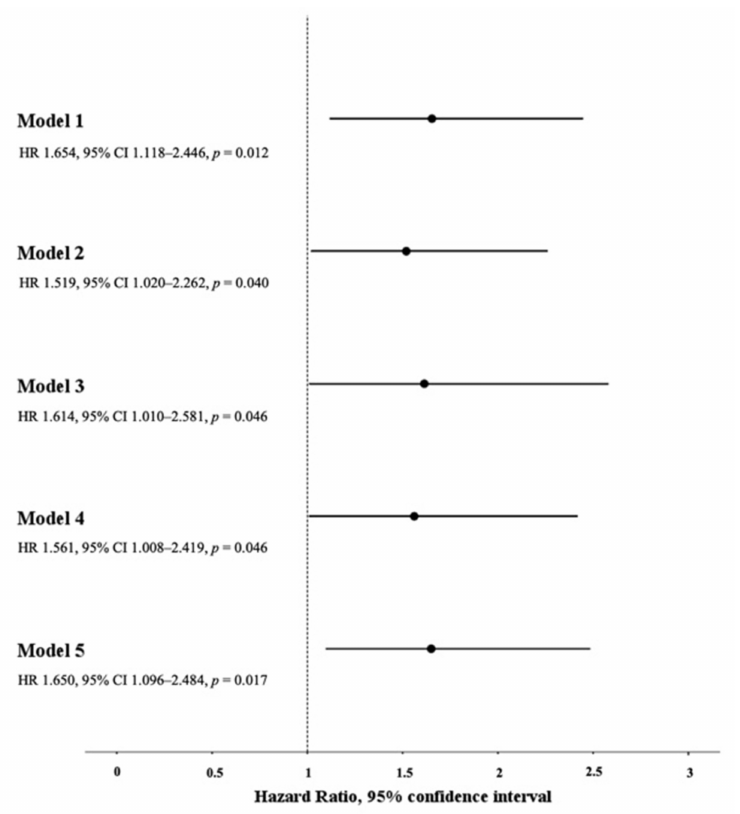
Figure 2. Association between low bFMD and the composite endpoint of ICU admission/in-hospital death in five Cox proportional hazard models (i.e., Models